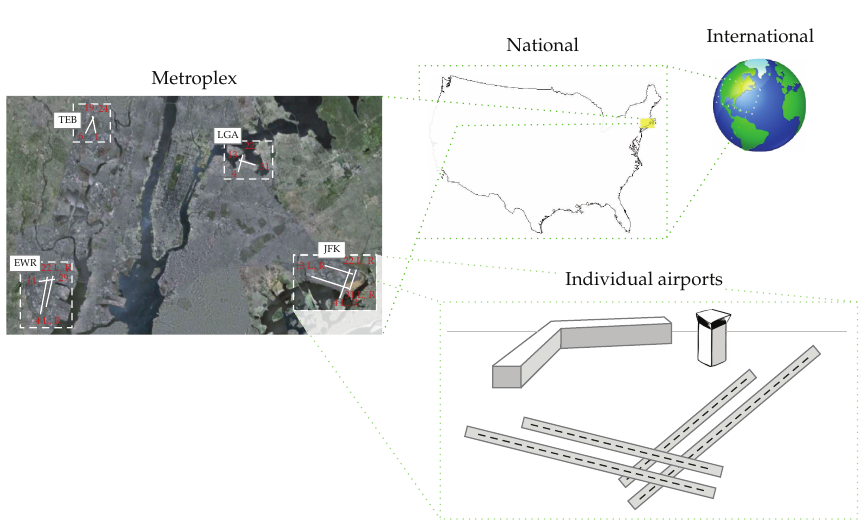
Figure 2: Decomposing the Air Transportation System into workable